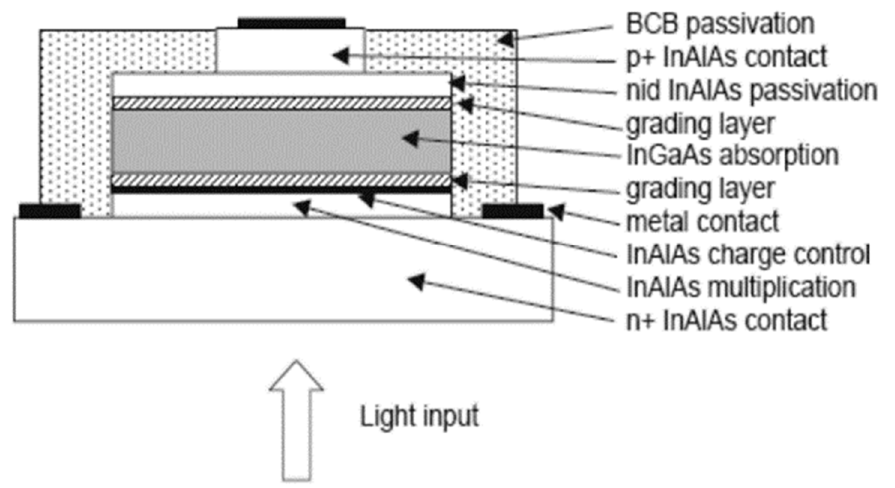
Figure 38. Schematic illustration for the backside illuminated InGaAs/InAlAs SAGCM APDs. Re- produced with permission from [92], IEEE, 2006.